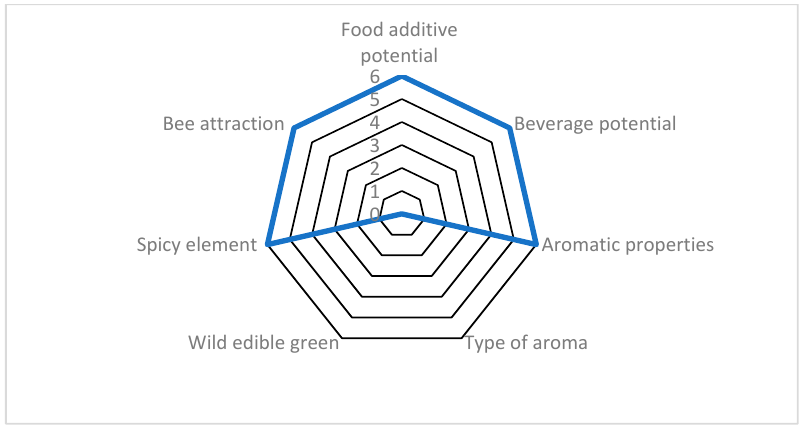
Figure 5. Evaluation example of Centaurium eythraea subsp. bifrons (endemic to the Mediterranean coast and Rif of Morocco) scored for seven agro-alimentary attributes, reaching 71.4% of the optimum possible score. This example is hierarchically ranked in the highest (>70%) class. For attributes and scoring, see Materials and methods.